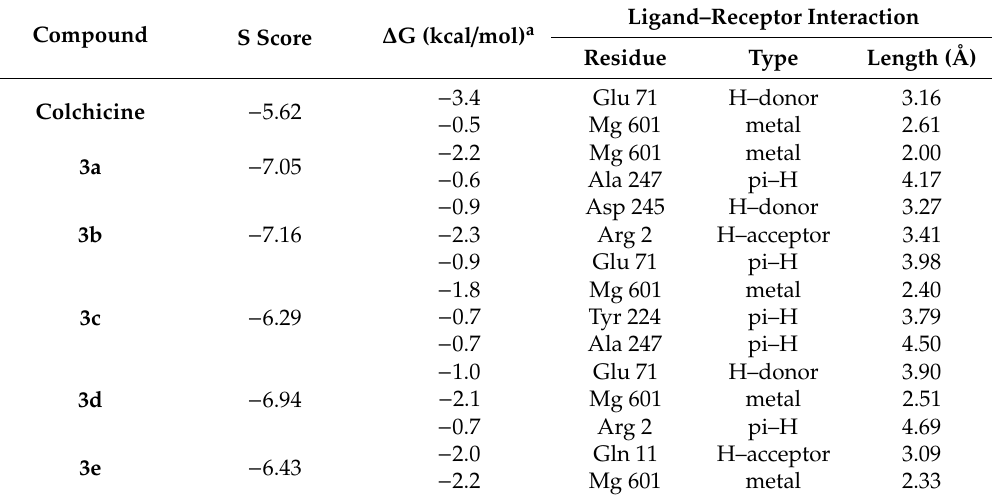
Table 9. Energy scores for the complexes formed by the tested compounds 3a – e and the reference colchicine in the active site of β -tubulin enzyme (PDB: 3HKC).